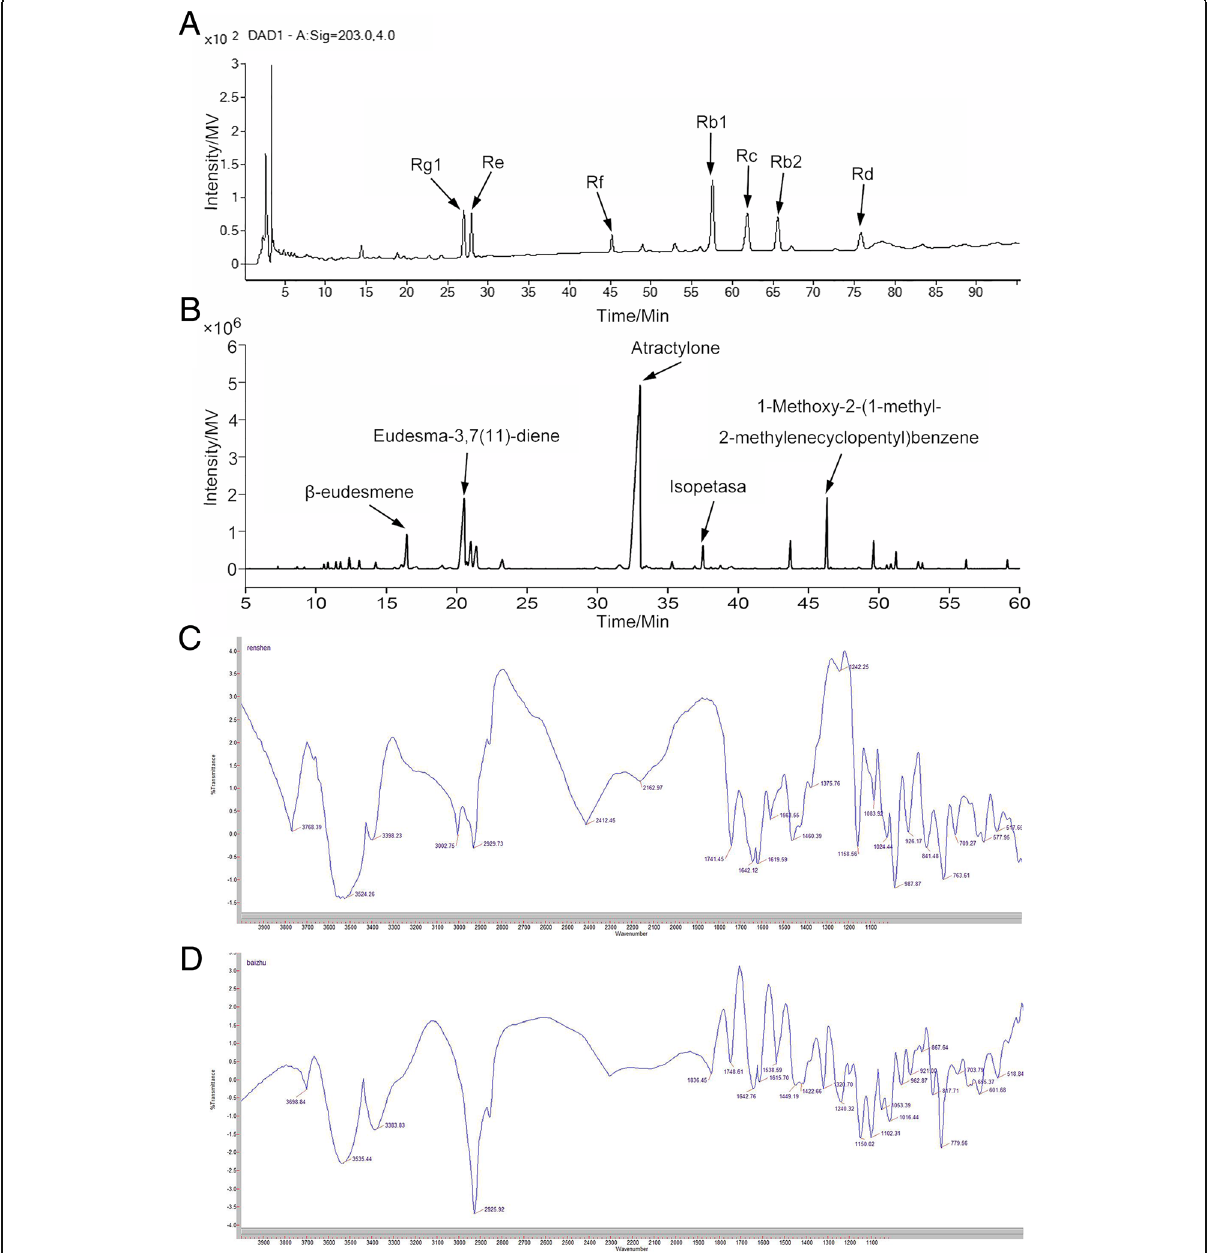
Fig. 1 Chemical characterization in SZC. ( a ) HPLC profile of ginsenosides from Renshen. ( b ) GC-MS profile of essential oil from Baizhu. ( c ) IR absorption spectrum of polysaccharides from Renshen. ( d ) IR absorption spectrum of polysaccharides from